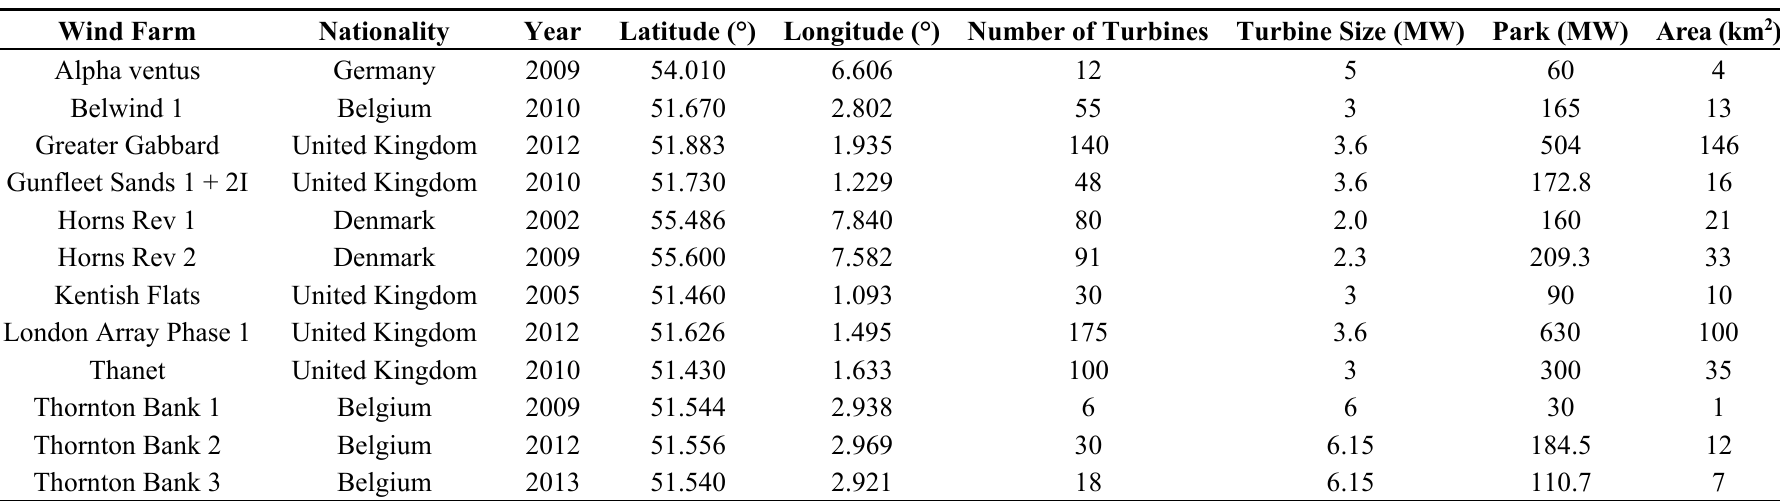
Table 2. Wind farm info: Country, start year of operation, approximated latitude and longitude, number and size of turbines, wind park capacity and area